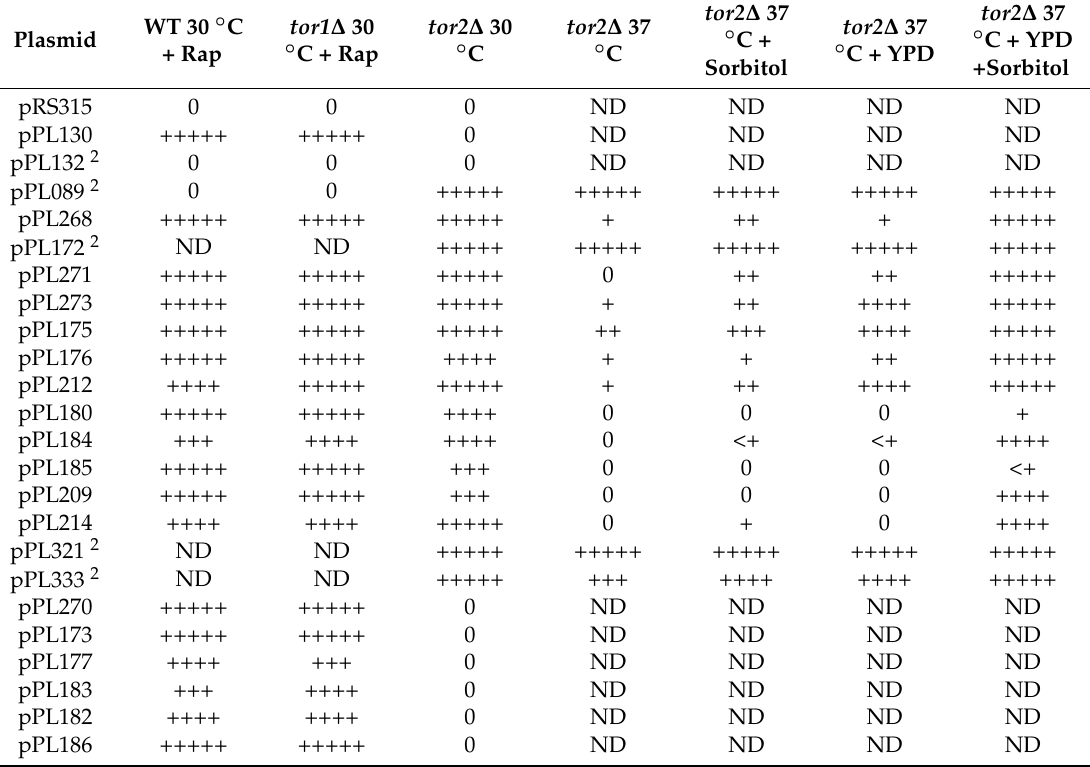
Table 1. Growth properties of TOR1 – TOR2 chimeras 1